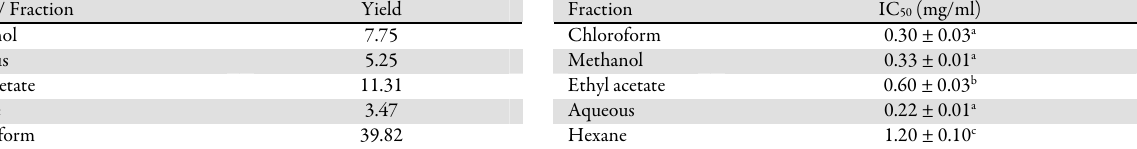
Table 1. Yield of C. odorata extract/ fraction Extract/ Fraction